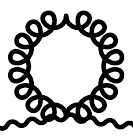
Figure 7. Diagram for vector coupling renormalization. Figure 8. diagram for vector coupling renormalization